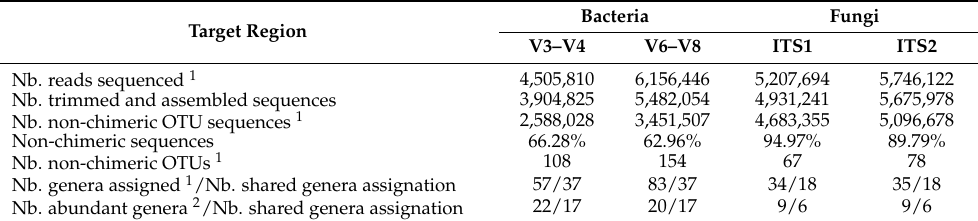
Table 1. Sequencing data of the fungal (ITS1 and ITS2) and the bacterial (V3–V4 and V6–V8) ecosystems. Bacteria Target Region